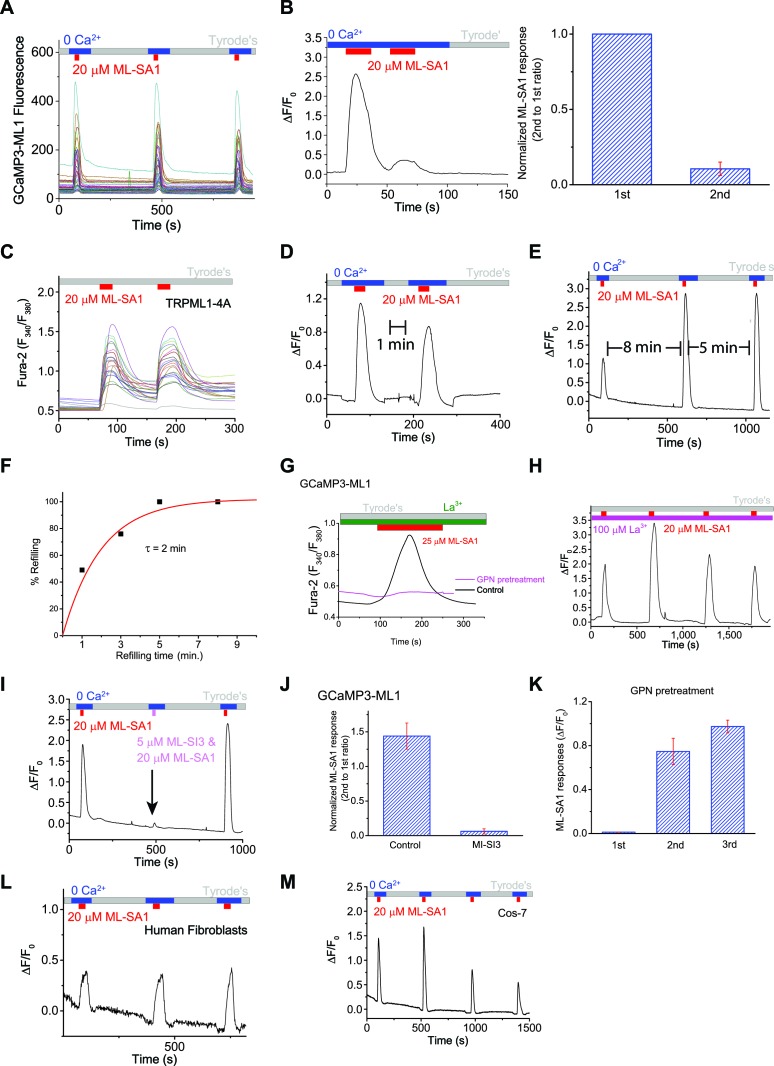
An assay to monitor lysosomal Ca2+ store depletion and refilling.(A) Raw traces of ML-SA1-induced GCaMP3 Ca2+ responses of individual HEK-GCaMP3-ML1 cells on one coverslip. (B) Immediate re-application of ML-SA1 showed a nearly-abolished lysosomal Ca2+ release. (C) In HEK293T cells transfected with surface-expressed TRPML1-4A channels, repeated applications of ML-SA1 induced comparable responses. (D) After 1 min refilling time, application of ML-SA1 in HEK-GCaMP3-ML1 cells induced responses that were smaller than the first one. (E) The amount of Ca2+ released after 8 min of washout and refilling was similar to the amount released after 5 min. (F) Time-dependence of lysosomal Ca2+ store refilling. (G) In the presence of La3+ (100 μM), a membrane-impermeable TRPML blocker, GPN pretreatment abolished ML-SA1-induced responses in HEK-GCaMP3-ML1 cells. (H) Lysosomal Ca2+ refilling in the presence of La3+. (I) ML-SI3 (5 μM) reversibly inhibited ML-SA1-induced Ca2+ responses in HEK-GCaMP3-ML1 cells. (J) Normalized ML-SA1 responses with and without co-application of MI-SI3. (K) Quantification of ML-SA1 responses shown in Figure 1C. (L) Lysosomal Ca2+ refilling in human fibroblasts transfected with GCaMP3-ML1. (M) Lysosomal Ca2+ refilling in Cos-7 cells transfected with GCaMP3-ML1. Panel B, D, E, G, H, I, L and M show the average response of 30–40 cells from one representative experiment out of at least independent repeats.